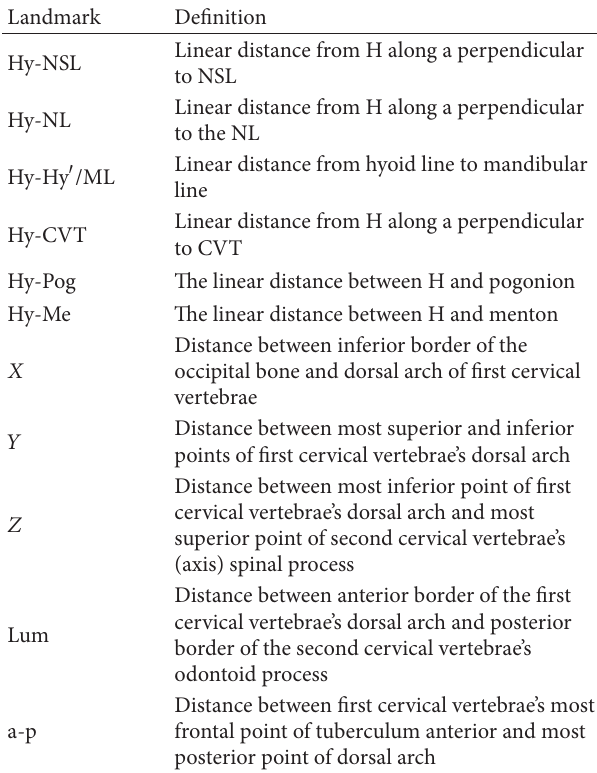
Table 3: Description of linear measurements.